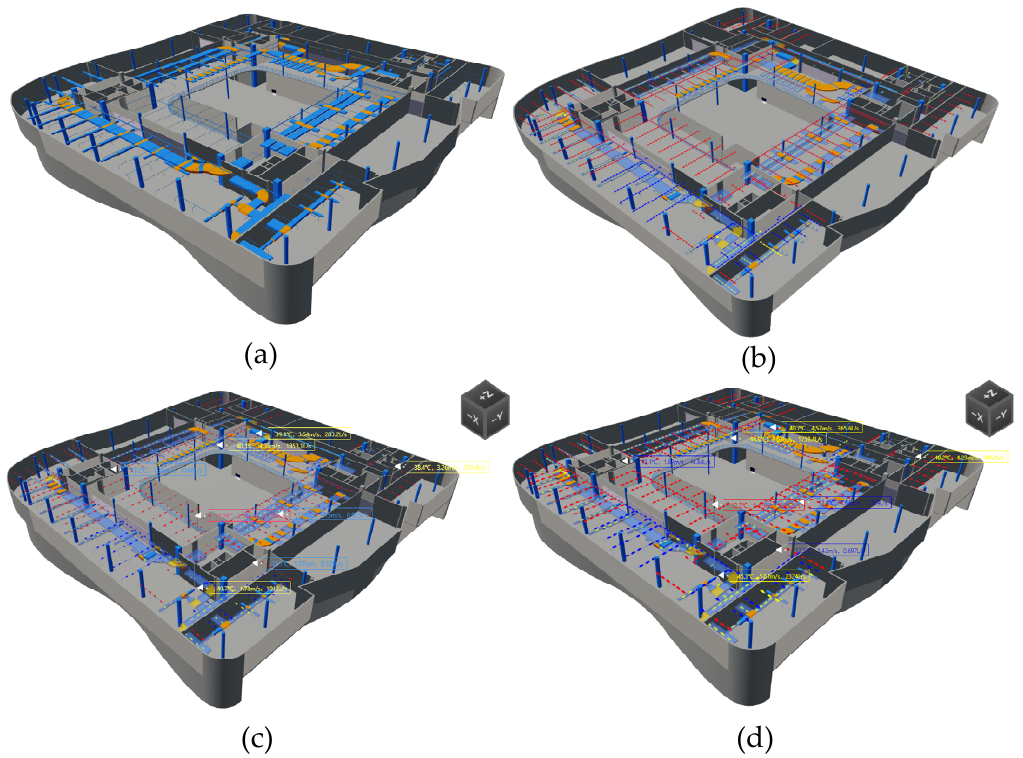
Figure 20a was a top view of the second floor of the library. MEP systems on the second floor contained 3310 MEP elements and three types of MEP systems (e.g., the fire-fighting system, the domestic water supply system, and the HVAC ventiduct system). Figure 20b was a top view of MEP systems of the library. The directed representative graph was composed of numerous arrows. The red arrows represented the firefighting system, the blue arrows represented the domestic water supply system, and the yellow arrows referred to the HVAC ventiduct system. Likewise, directions of arrows represented flow directions of MEP systems. The flow at the start of the experiment is shown in Figure 20c,d, illustrating the flow at the end of the experiment. Obviously, as the velocity and the flow rate increased, the density and the size of arrows became large.